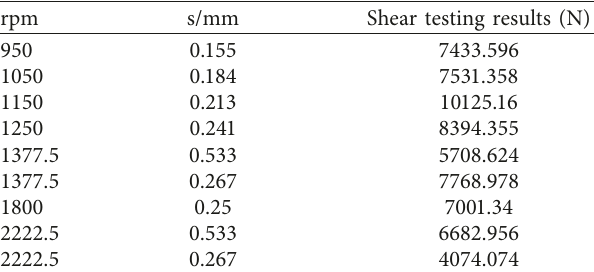
Table 11: Shear testing results of averaged failure loads.